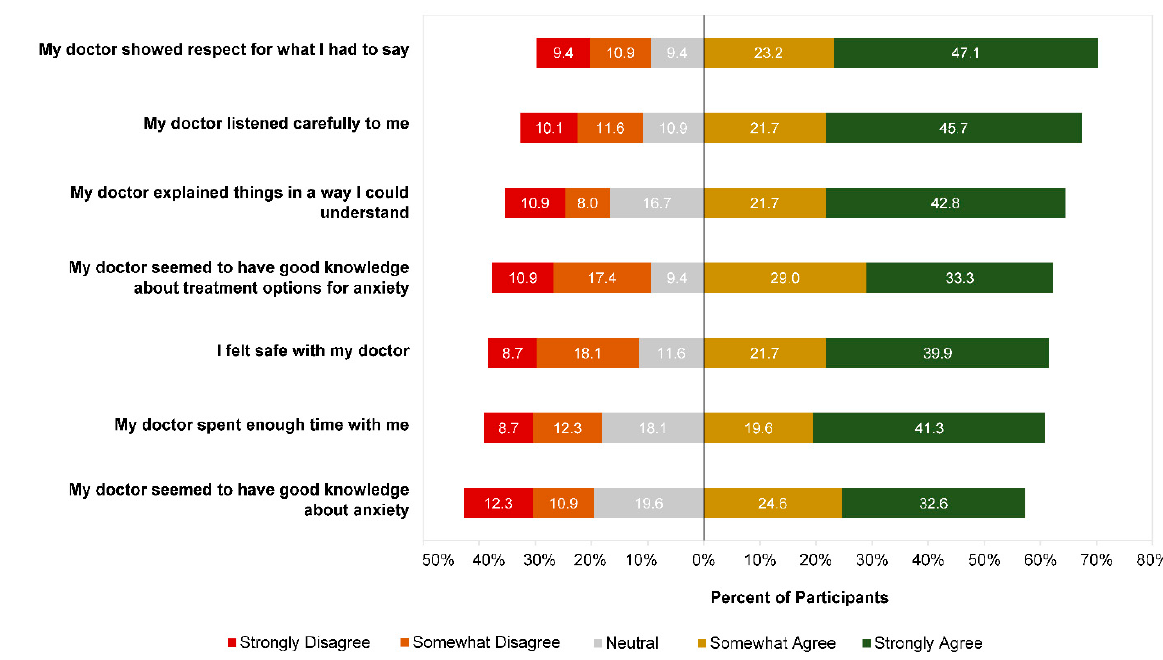
Figure 4. Participant ratings (n = 138) of perceptions of GP at first experience.